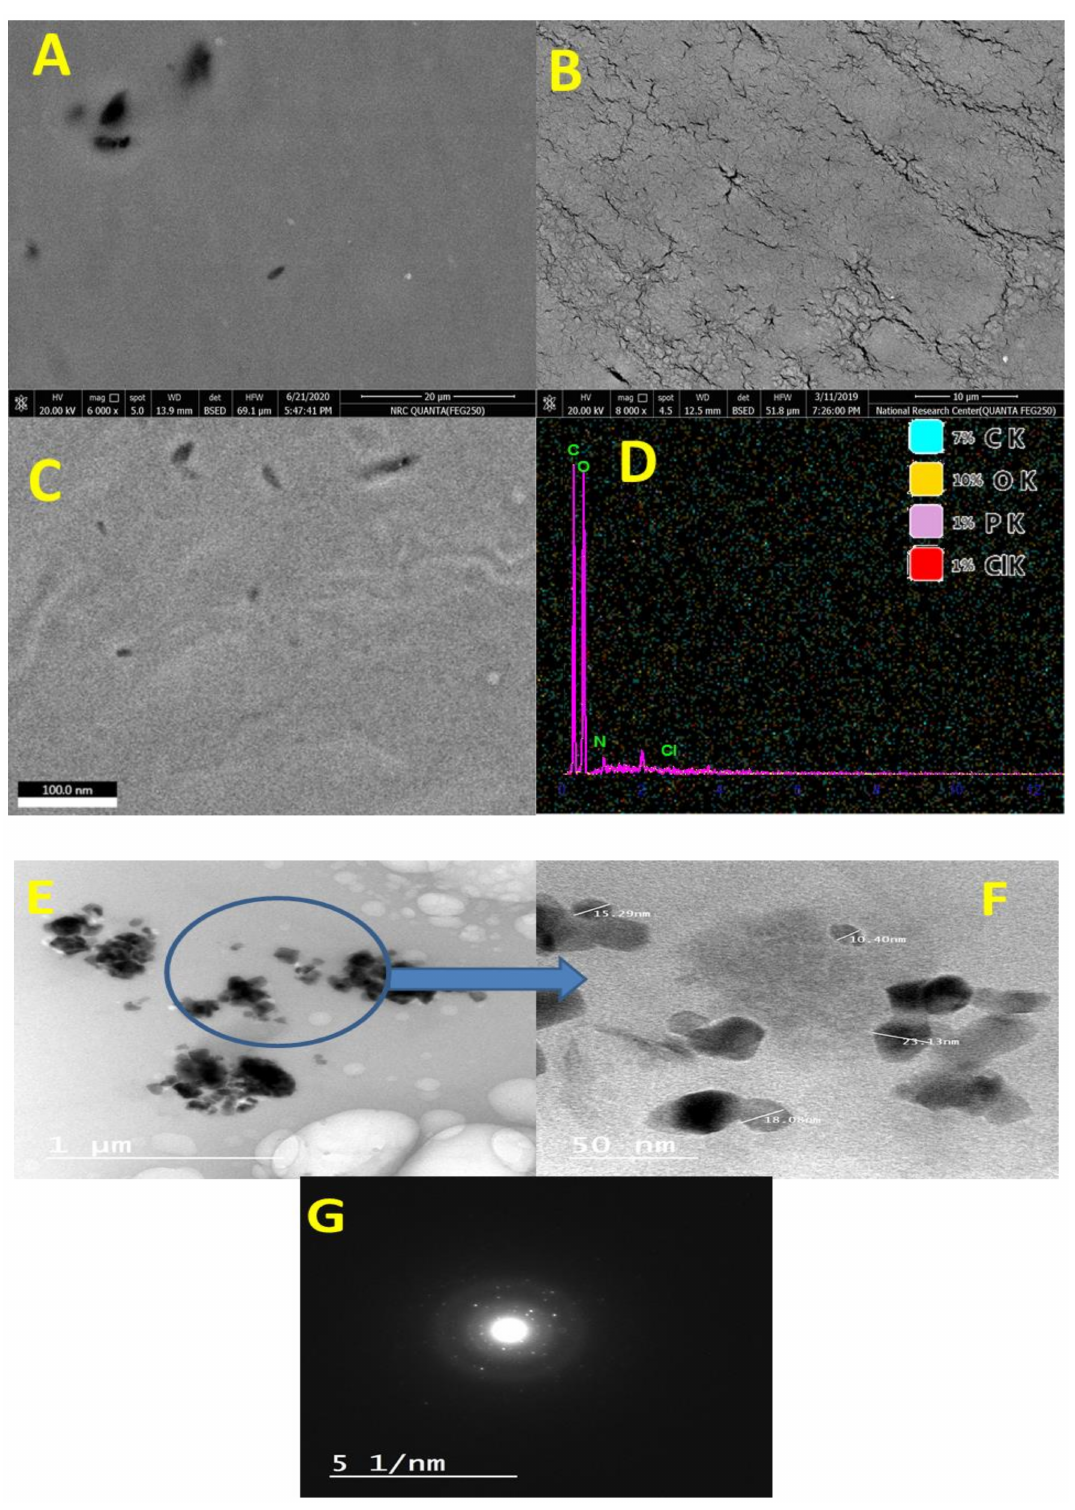
Figure 3. Scanning electron microscope topography of glycogen ( A ), gelatin ( B ), green nanocomposite-based biopolymers (Ge-Nco) ( C ), and mapping as well as energy dispersive X-ray chart ( D ). Transmission electron microscope of green nanocomposite-based biopolymers at low magnification ( E ), at high magnification ( F ), and diffraction of nanoparticle ( G